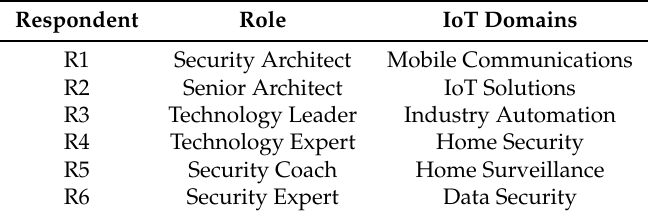
Table 1. Interviews with experts: their role and domains.